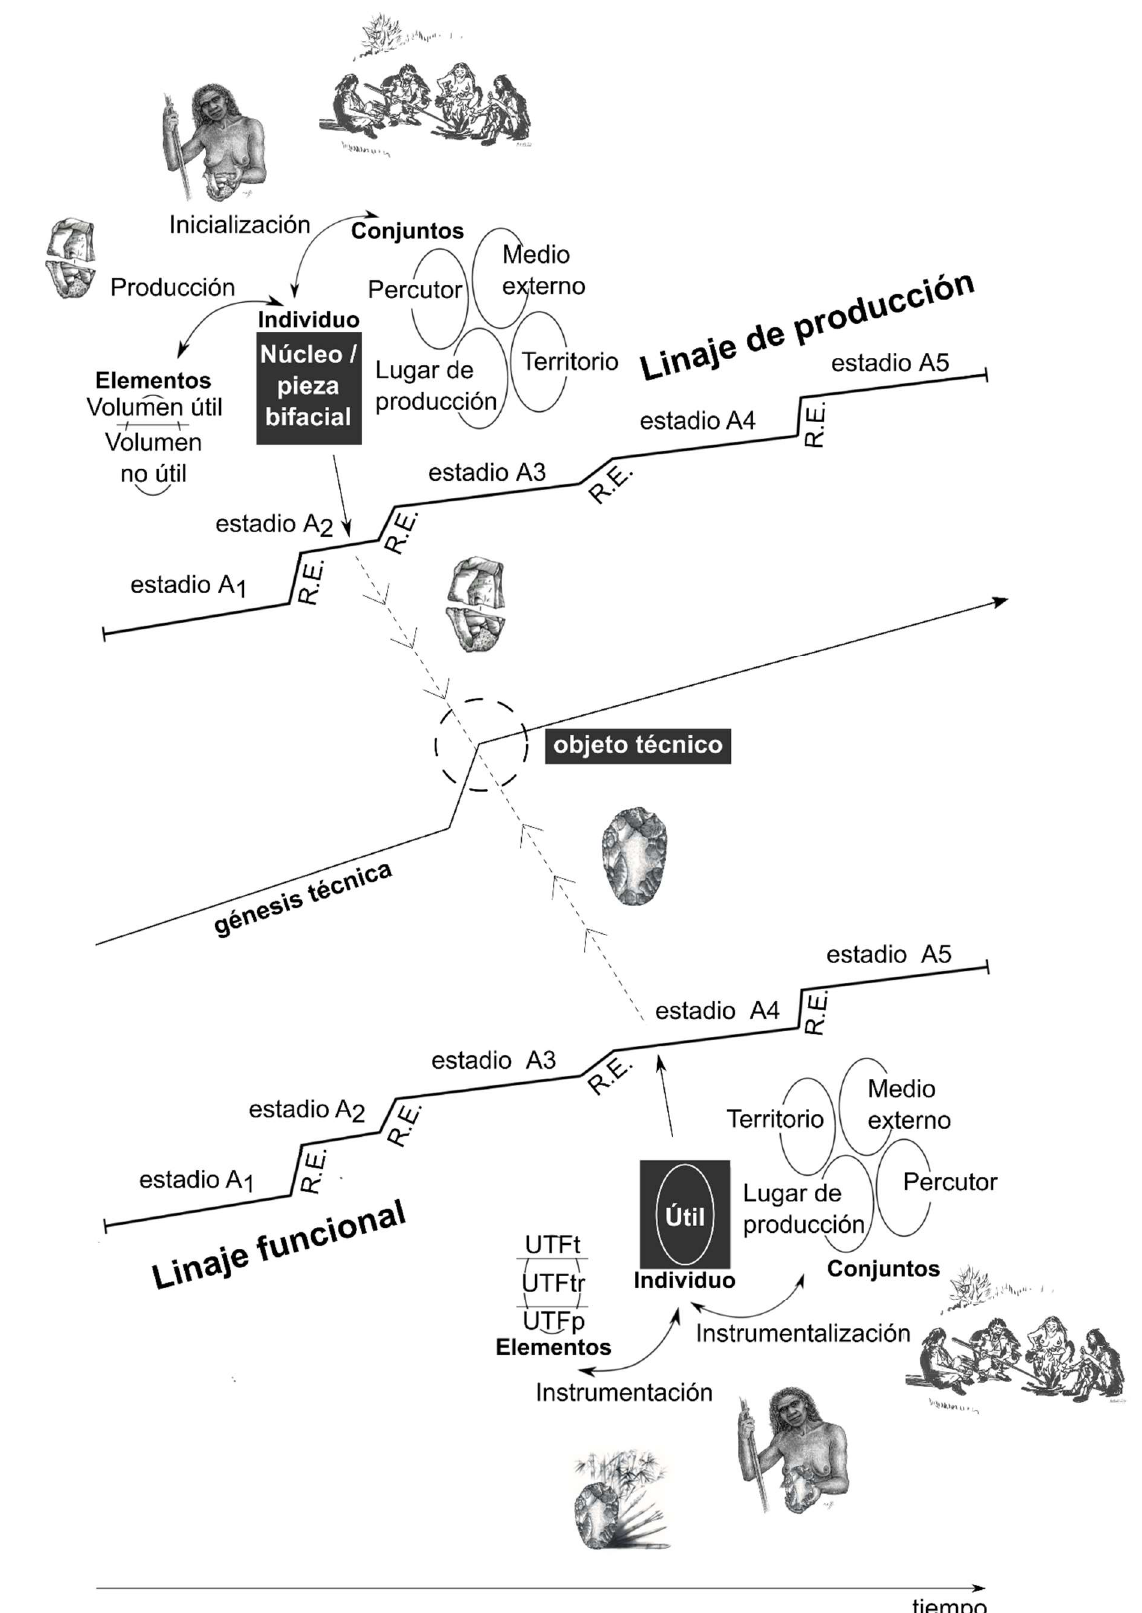
Figura 14. Estructura de los linajes técnicos en prehistoria: los linajes de producción y de función son independientes en un punto dado del análisis, pero luego deben abordarse juntos para tratar de comprender la génesis técnica . Los dibujos fueron realizados por Maxence Raffi y Aurore de